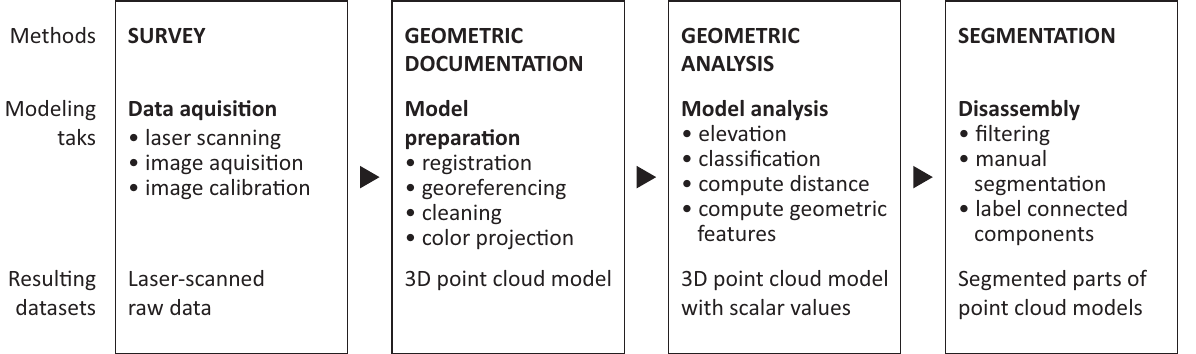
Figure 3. Steps to use laser-scanned data as a source for geometric documentation and analysis for an investigative purpose in landscape